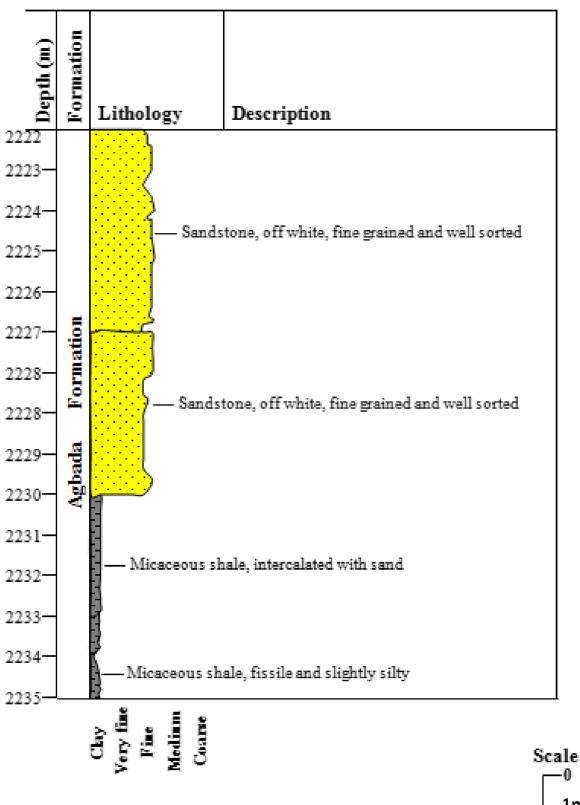
Fig. 3 Lithological log of selected cores at different depths in PZ-2